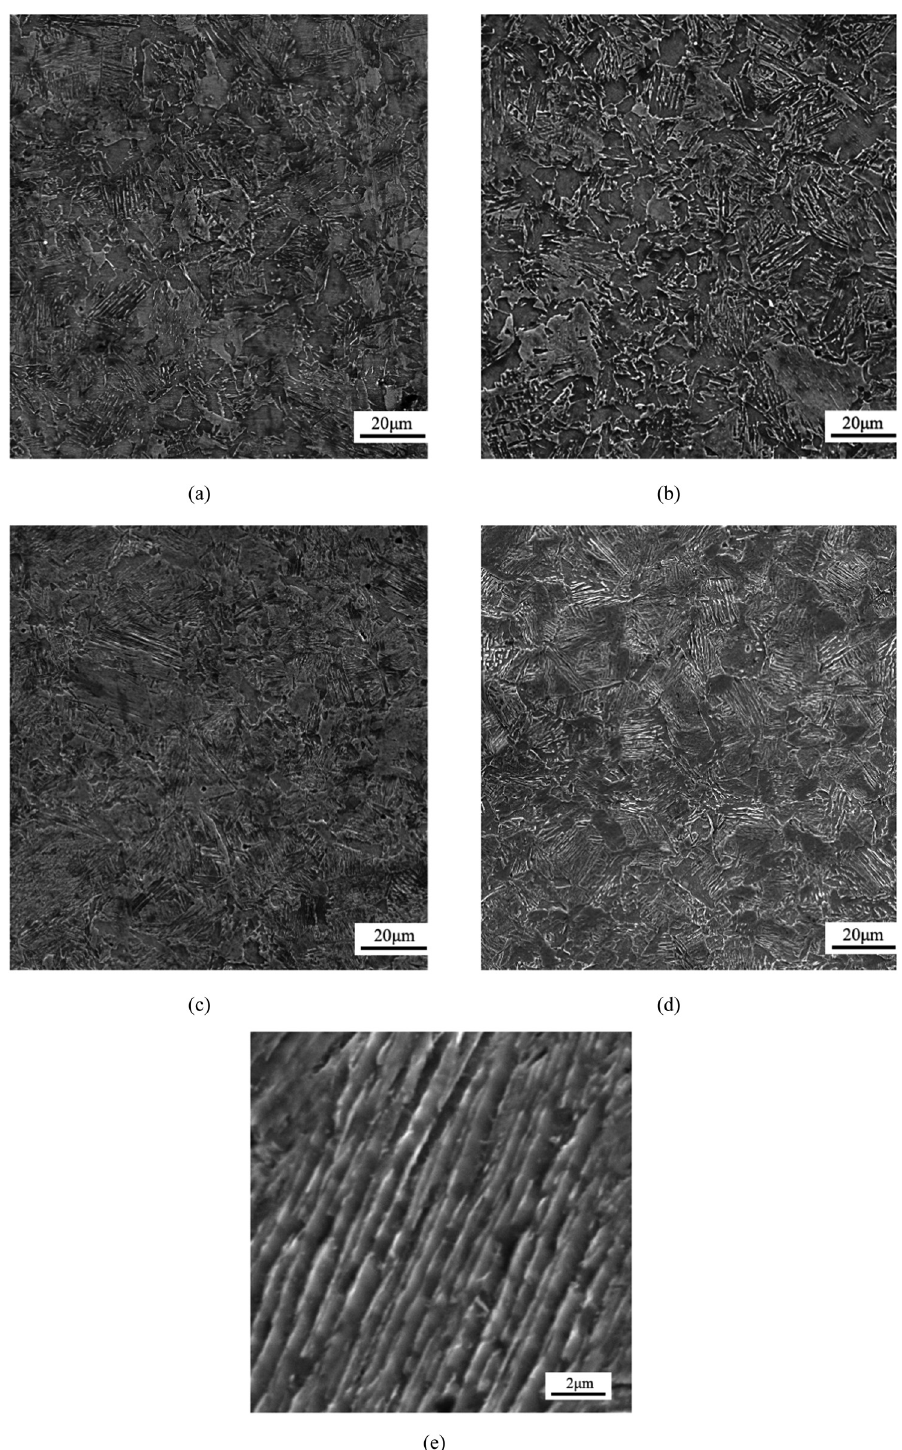
Figure 9: SEM images of the specimens quenched from 960°C with the cycle steps of ( a ) one cycle, ( b ) two cycles, ( c ) three cycles, ( d ) four cycles and ( e ) four cycles, 5,000 ×